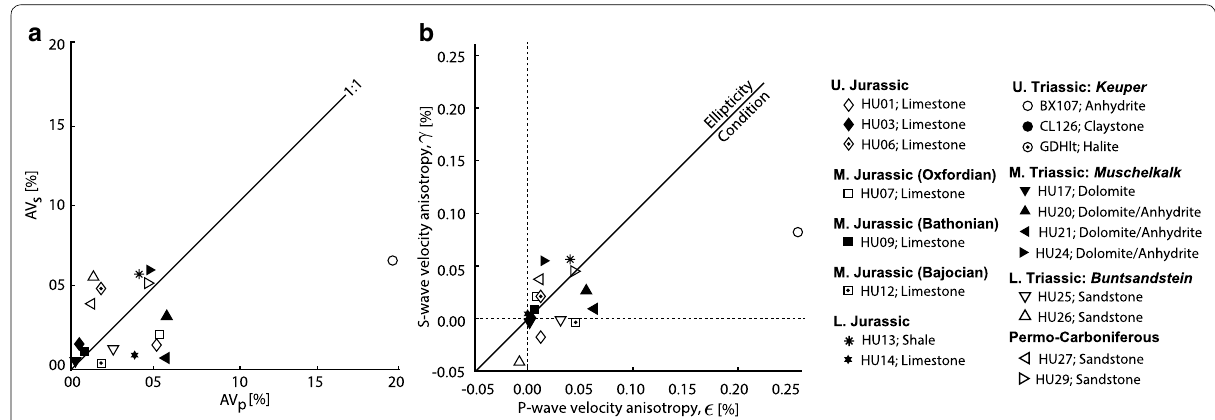
Fig. 10 Cross-plots of a P-wave and S-wave velocity anisotropy as a percentage b P-wave ( ǫ ) and S-wave ( γ ) velocity anisotropy parameters expressed as percentages. Error bars for ǫ and γ are too small to be visible. Note negative